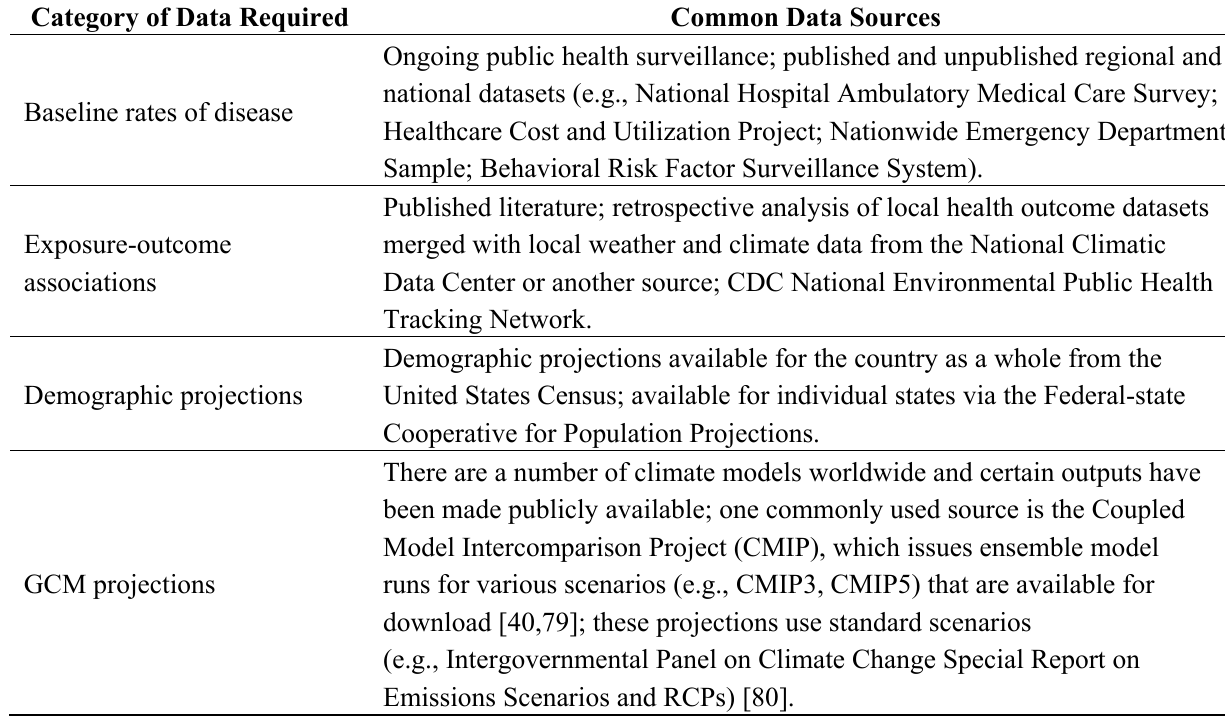
Table 2. Common data sources used in climate change health impact projections (adapted from Hess et al. [7] with permission from Springer ®